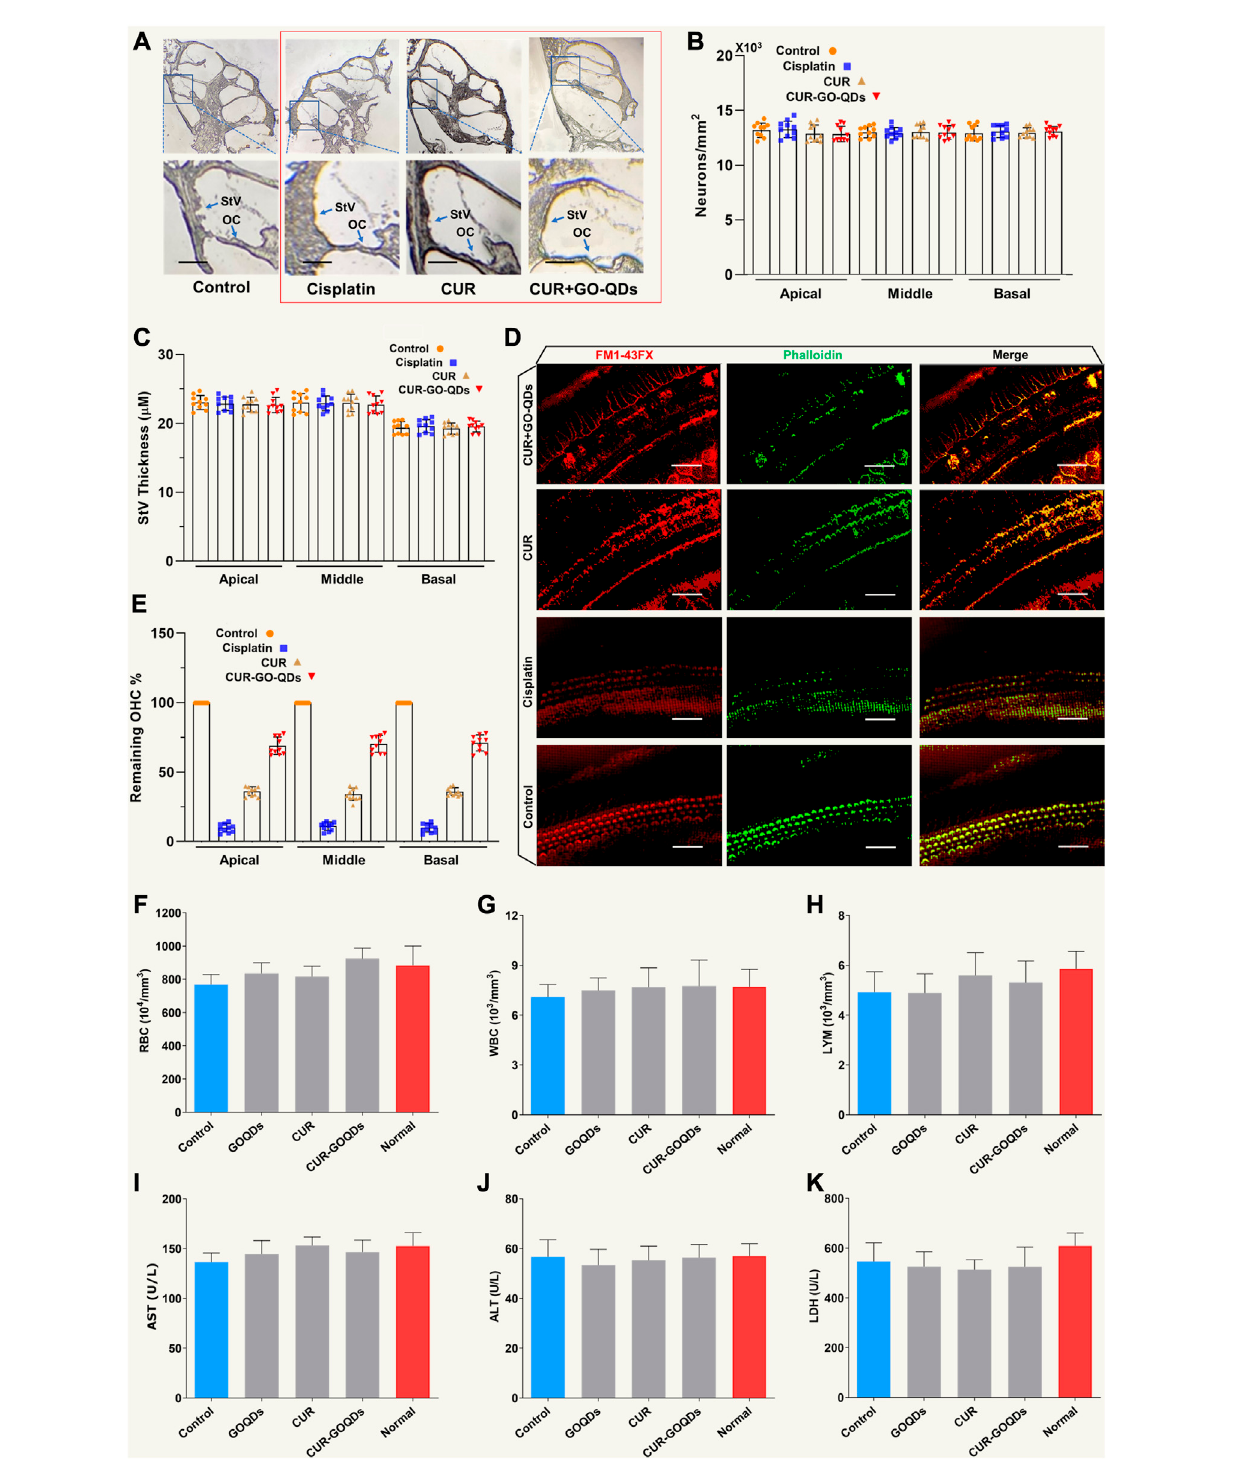
FIGURE 8 CUR/GOQDspartiallyrestoredCIS-inducedhearinglossininguineapigs. (A) H&Estainingwasperformedonthetransversesectionoftheguineapig cochleatreatedwithdifferentCIS. (B) SeveredegenerationofHCswasobservedintheOC(Cortiorgan)inguineapigstreatedwithhigh-doseCIS,butnot inthecontrolgroupandCUR/GOQDsgroup.However,therewerenosigni fi cantdifferencesinSGNandStVamongthethreegroups.Thesurvivalpattern and StV thickness (C) of ganglion cells were similar among the four groups. (D) In vitro culture of Corti organs. Phallioidin and FM1-43FX staining images of the cultured cochlear sensory epithelium treated with CIS. (E) By analyzing the number of cochlear revolutions in different treatment groups, theOHCsthat survived after CIS treatment were quantitatively analyzed; n = 10. (Scale bar: 20 µm) Peripheral blood was collected in the presence of the anticoagulant EDTA and analyzed using a hematological analyzer. Red blood cells (F) , white blood cells (G) , and lymphocytes (H) were analyzed separately. Peripheral blood cell analysis showed no signi fi cant decrease in lymphocytes in the CUR-GOQDs treatment groups compared to normal guineapigs (I – K) .Comparedtothecontrolgroup,thelevelsofAST,ALT,andLDHinthetreatedratsslightlydecreased.Dataarepresentedasmean±SD, ** p < 0.01, using two-tailed Student ’ s t